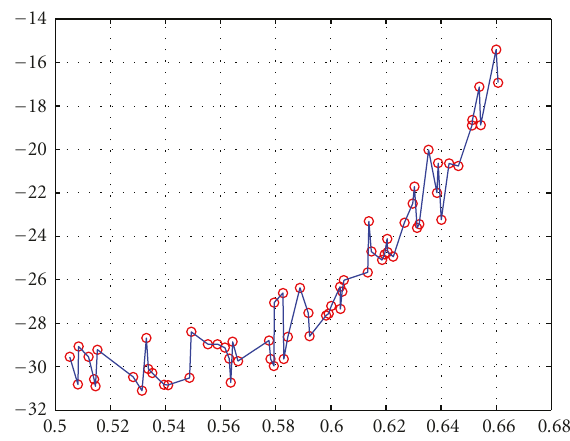
Figure 11: Original signal irregularly